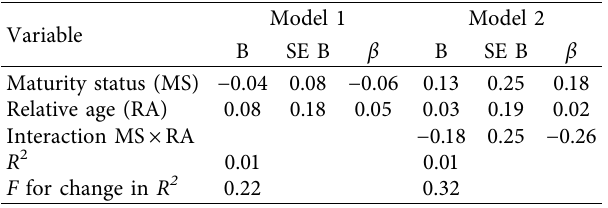
Table 7: Summary of hierarchical regression analysis for variables predicting RSI